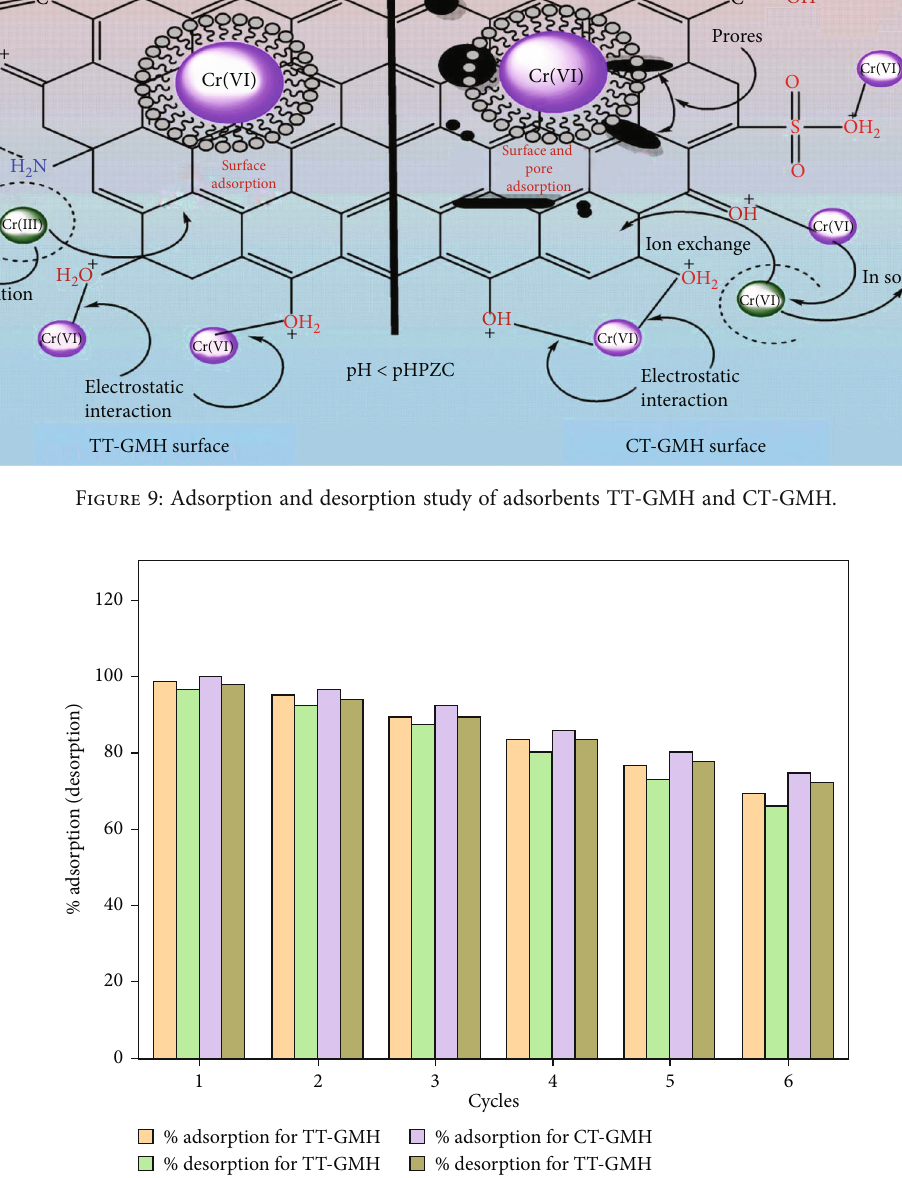
Figure 10: Adsorption and desorption study of adsorbents TT-GMH and CT-GMH.